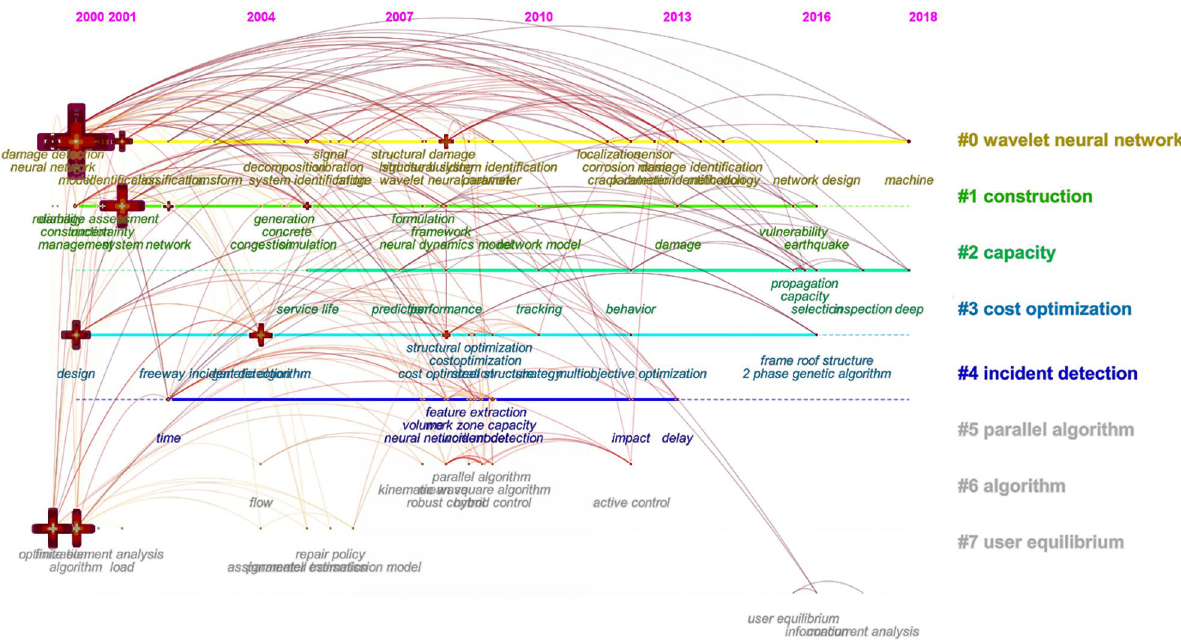
Figure 12. The timeline view of keywords in the CACAIE